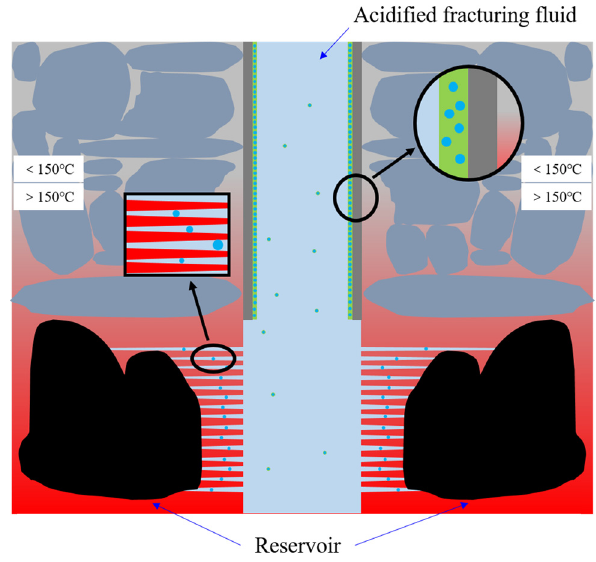
Figure 10: The mechanism of nano - SiO 2 @OBQA ( the color of the formation changes from gray to red, indicating that the temperature of the formation increases with the increase in depth )